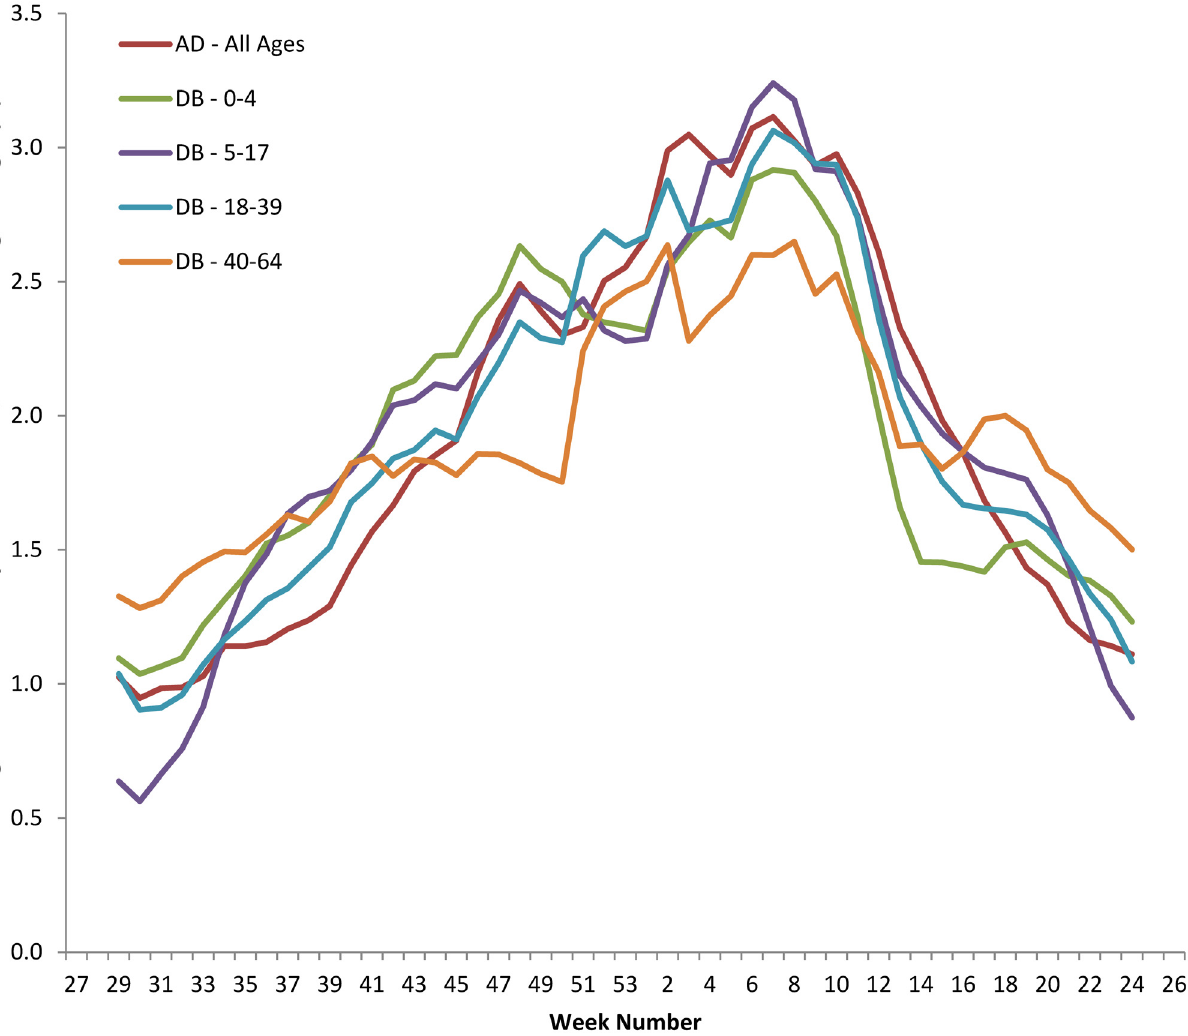
Fig 4. Weekly percent of total norovirus-attributable medical encounters; 5-week moving average by week of year and population. The percentage of estimated norovirus-attributable medical encounters for each week of the year were calculated for each population/age group as follows: the number of encounters occurring in a given week was averaged over the entire study period for each respective group, then expressed as a percentage of the sum of all weekly averages for that population/age group. Five-week moving averages of these values were calculated and plotted for each population/age group. AD: Active duty; DB: Dependent beneficiary; age group range in